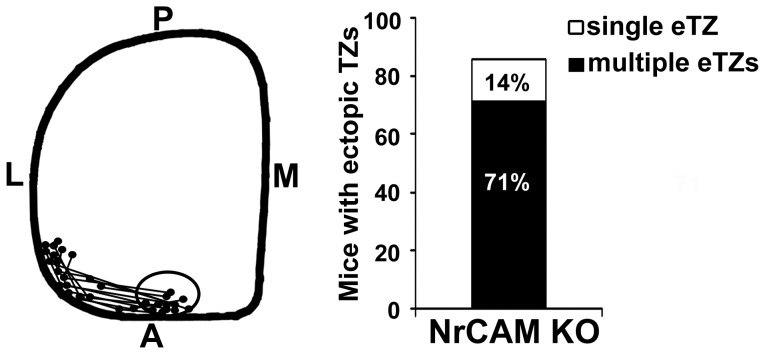
Distribution and Percentage of Termination Zones of Temporal RGC axons in the NrCAM Null Superior Colliculus.
Left panel: The schematic diagram illustrates the location of TZs of temporal RGC axons in the NrCAM null mutant (KO) SC (P10). The centers of TZs and eTZs from NrCAM KO mice (n = 14) are marked and connected. The distribution of normal TZs of temporal RGC axons in WT mice are all found within the anterior region of the SC depicted by the oval. L, lateral; M, medial; A, anterior; P, posterior. Right panel: Percentage of abnormally distributed single and multiple eTZs of temporal RGC axons in the SC of NrCAM null mice (P10). In NrCAM KO mice 85% of mice showed abnormally located eTZs. A single laterally displaced eTZ is found in 14% of mutants, and multiple eTZs were found in 71% of the mutants.